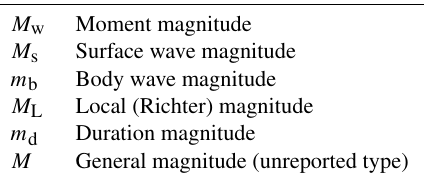
Table 1. Symbols for different magnitude scales in the priority order of magnitude